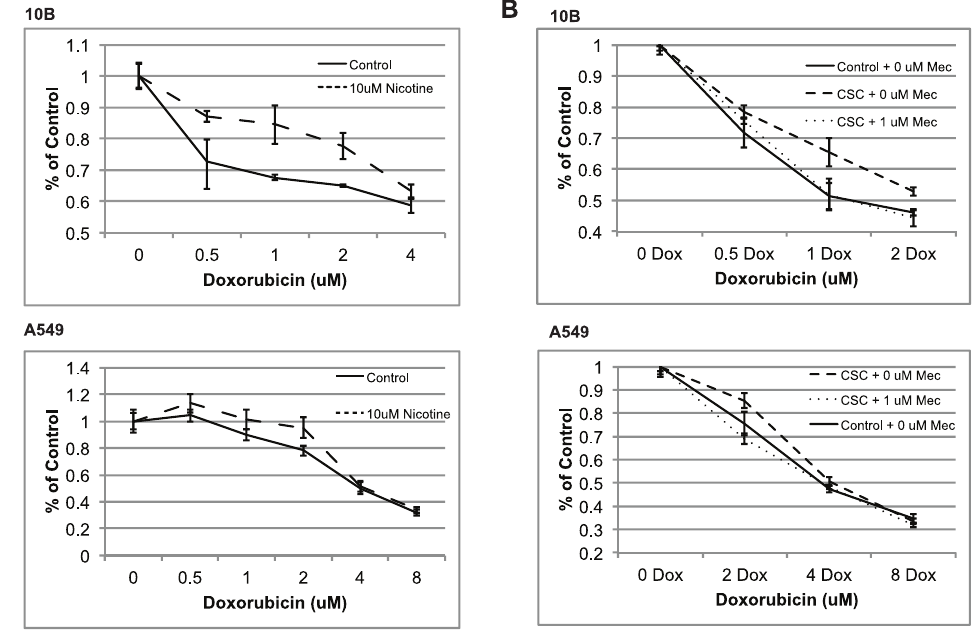
Figure 8. Nicotine-treated cells show enhanced viability during doxorubicin exposure. ( A ) MTS proliferation assay testing the viability of control vs. nicotine-treated cells in the presence of doxorubicin. Absorbance (Y-axis) values were normalized by dividing over the absorbance of the 0 m M doxorubicin samples. (B) MTS viability assays demonstrating the reversal of CSC-induced doxorubicin resistance by the nAChR inhibitor mecamylamine. Taken together, these results indicate that nicotine is at least partially responsible for the protective effect of CSC against doxorubicin-induced cell death. Error bars represent SEM.